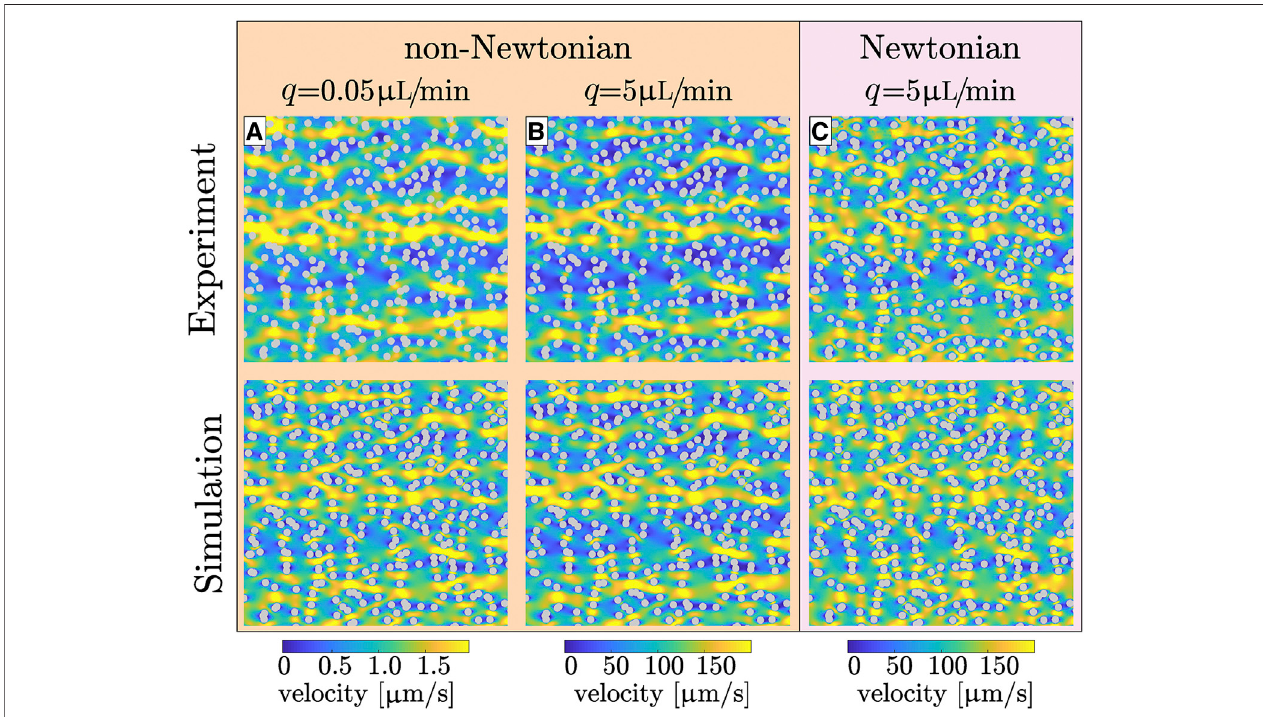
FIGURE2| Comparisonoftheexperimentallymeasured[42]andsimulatedvelocity fi eldsinthemidplaneoftheporousdeviceforthetwonon-Newtoniancasesat (A) qin 0.05 µL/min, (B) qin 5 µL/min, and for the Newtonian case (C) . Note the different velocity ranges between (A – C) . For comparison, the color scales has been normalized to the 95% quantile of the velocity